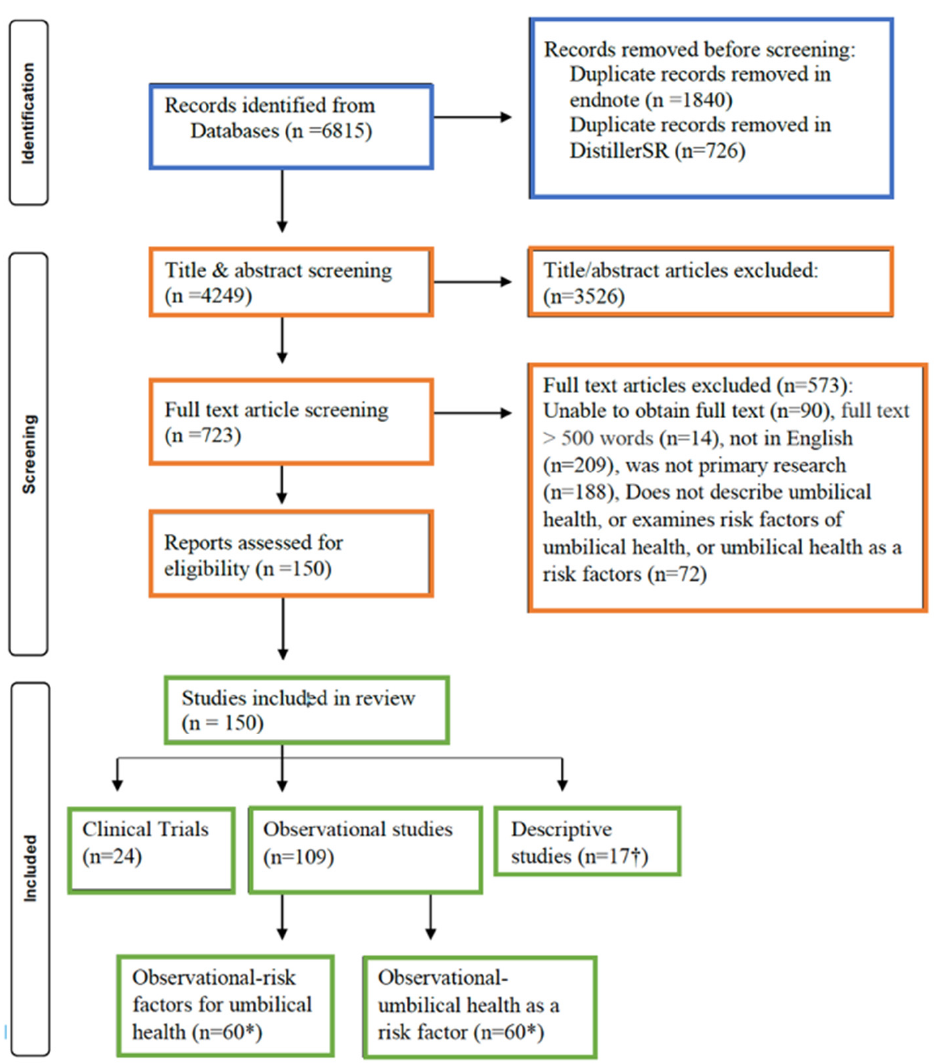
Figure 1. Preferred Reporting Items for Systematic Reviews 827 and Meta-Analysis (PRISMA) flow